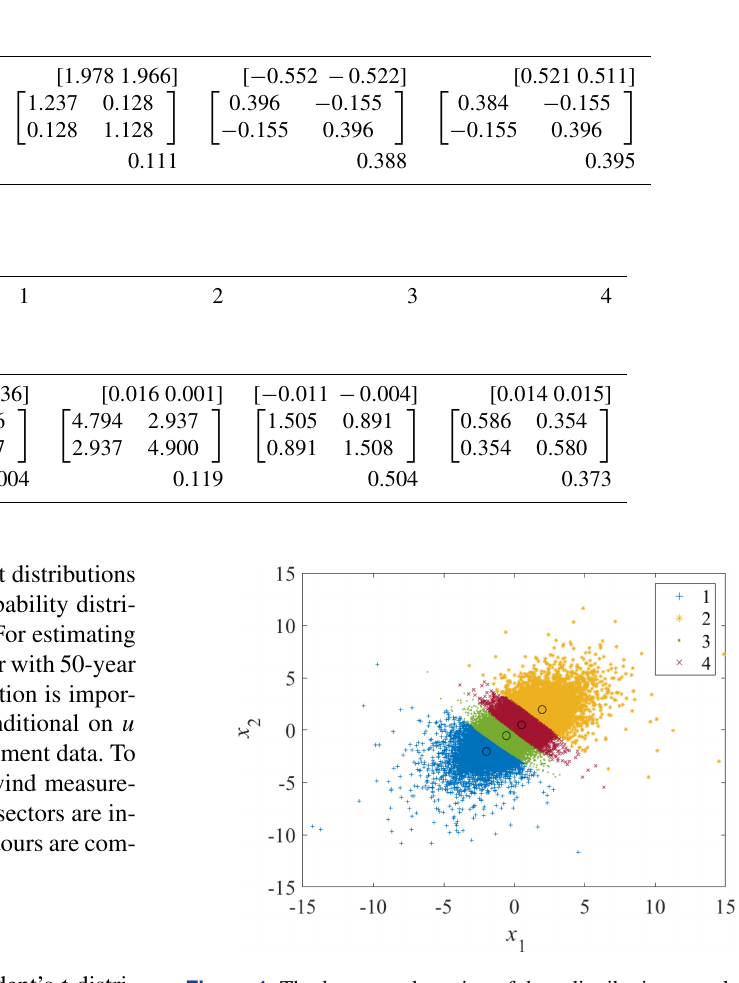
Figure 1. The k -means clustering of the t distribution sample.